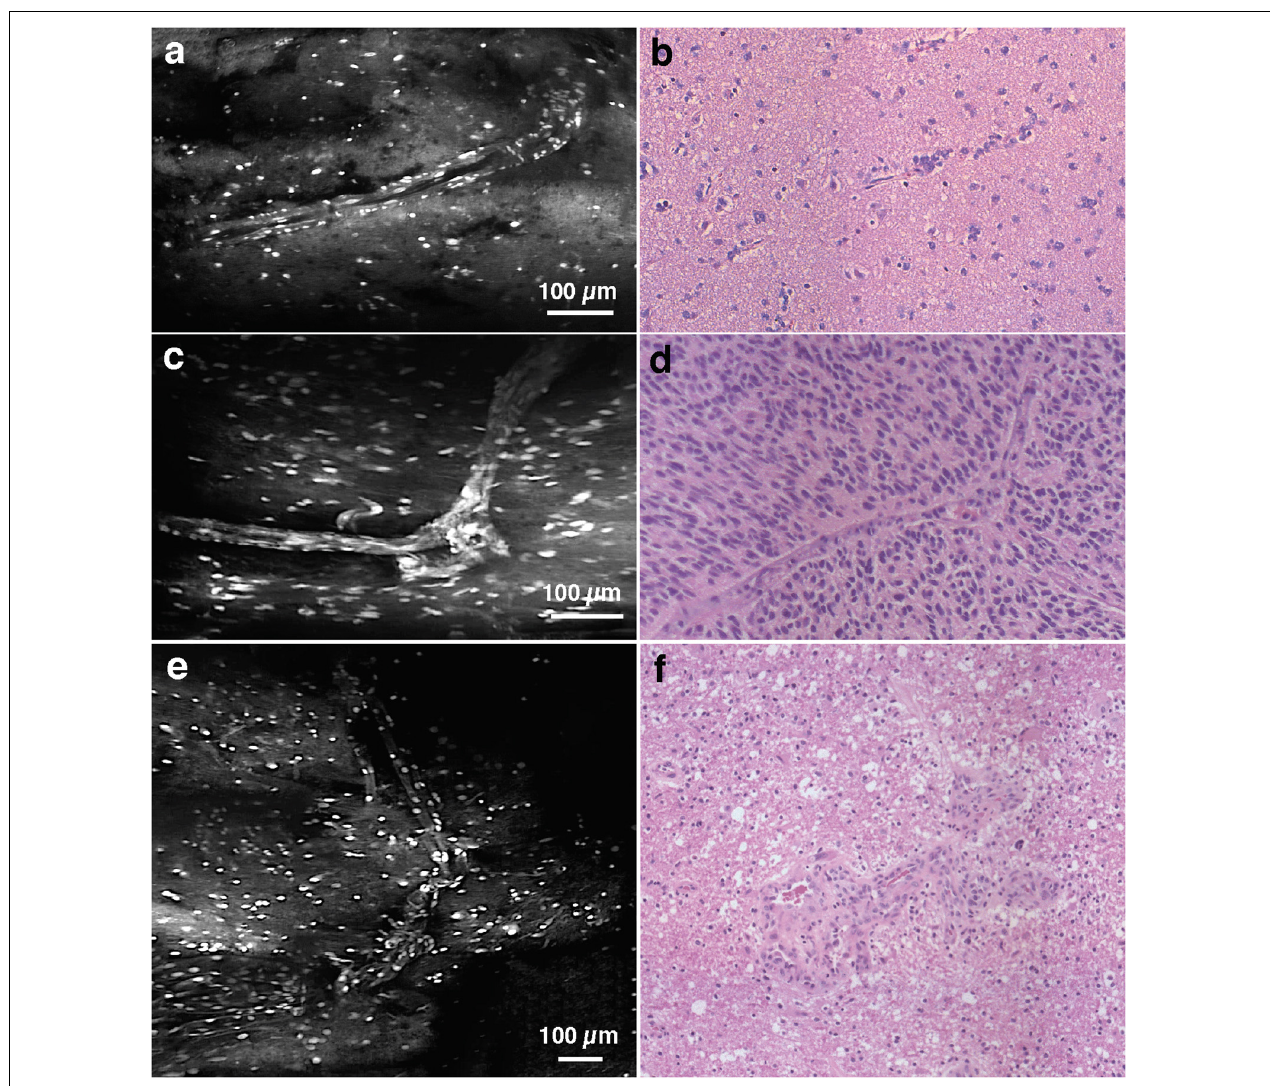
FIGURE 4 | Vasculature. (a) LS-DAC image showing the vasculature in human gliomas (topically stained with acridine orange) with (b) corresponding H&E histology. (c–f) Additional LS-DAC images of human glioma vasculature acridine orange staining with corresponding H&E histology. LS-DAC, line-scanned dual-axis confocal; H&E, hematoxylin and